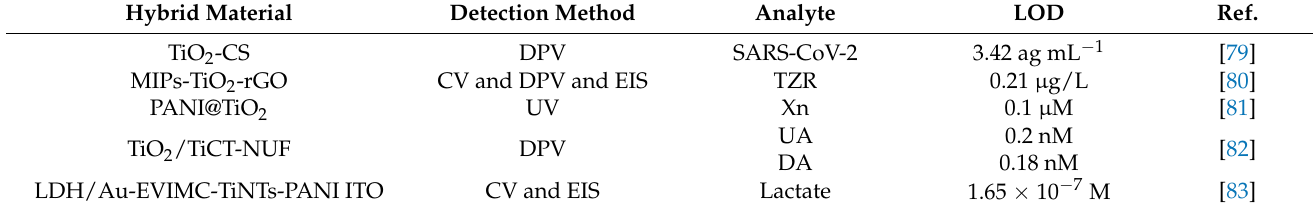
Table 2. Summary of organic materials hybridized with TiO 2 for biosensor applications.